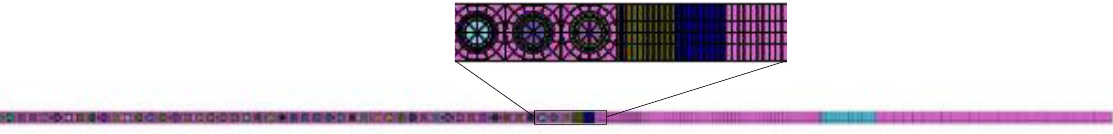
Figure 2. TDT/MOC spatial mesh for a BEAVRS traverse.